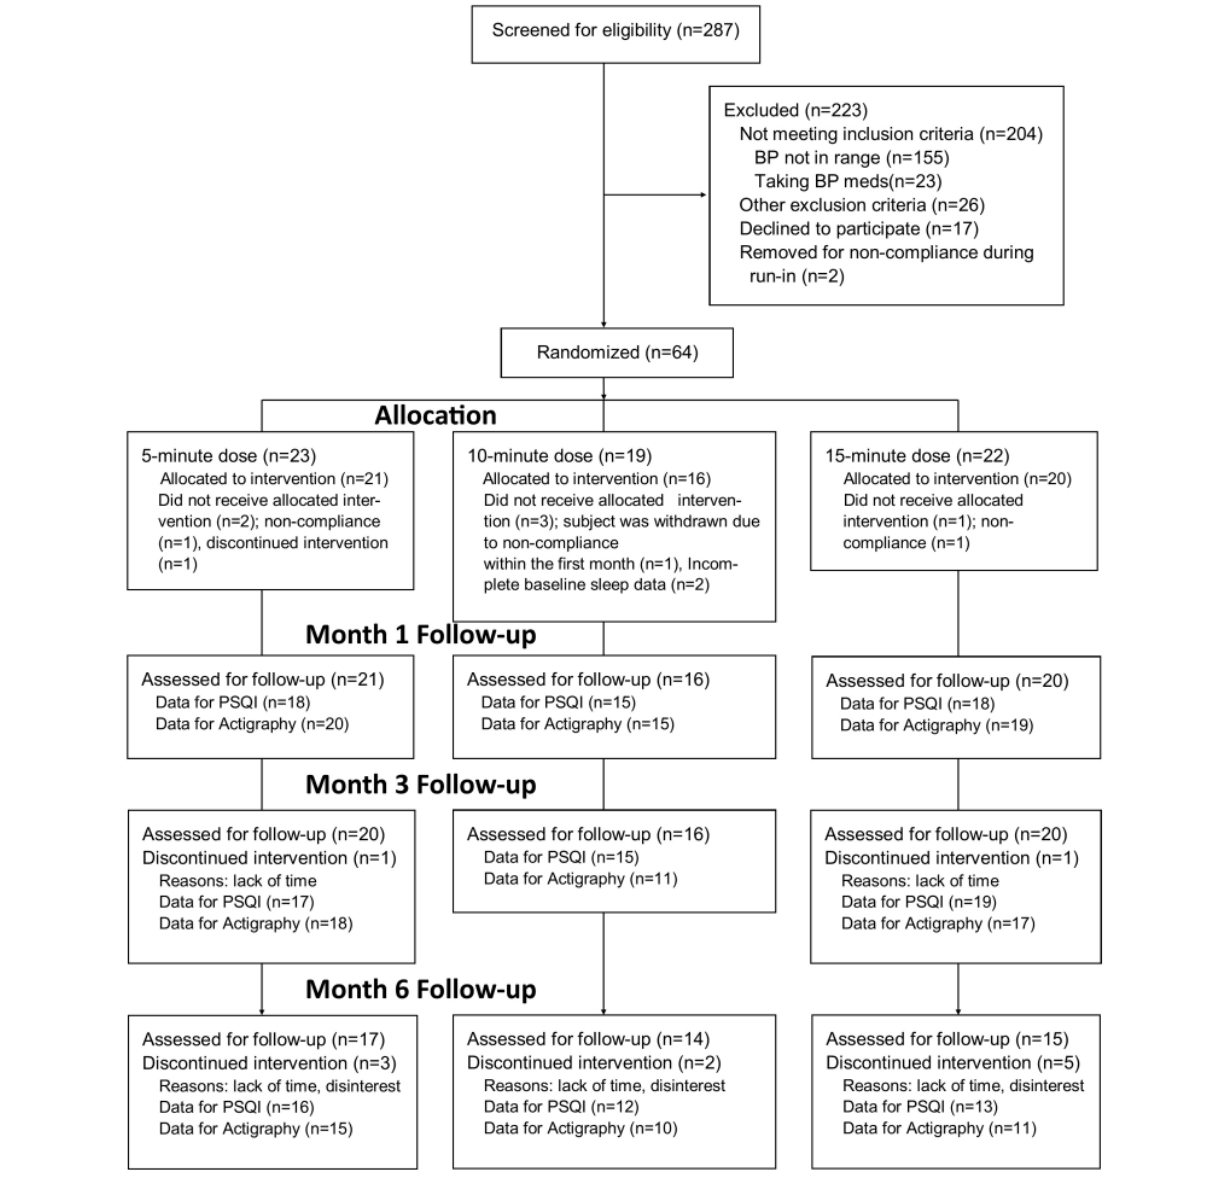
Figure 2. Recruitment and assessment flow diagram. PSQI: Pittsburgh Sleep Quality